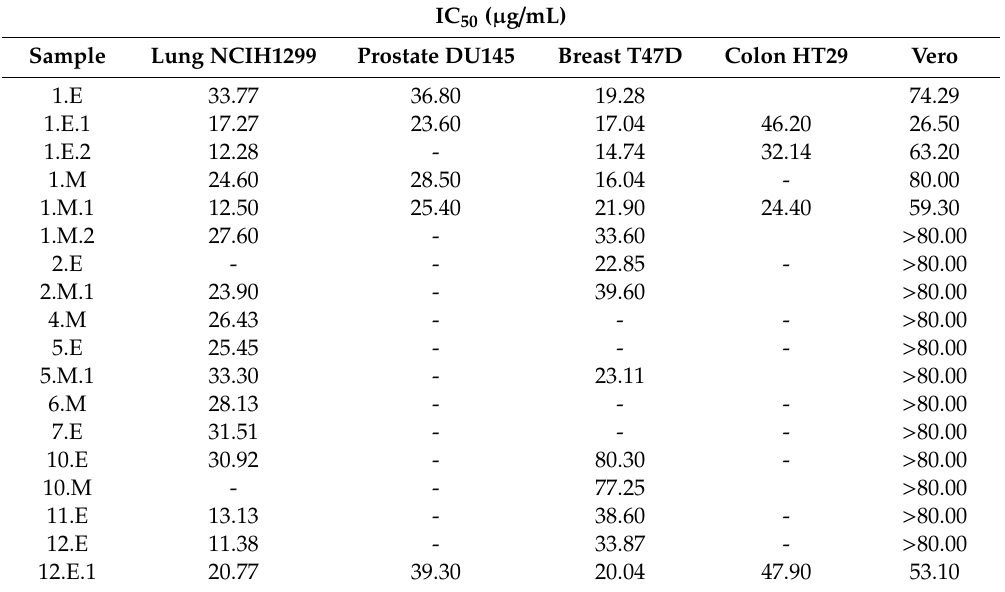
Figure 1. Cell survival against NCI-H1299 lung cancer cell line of samples (beach-cast extracts and fractions) tested at two concentrations (20 µg/mL and 50 µg/mL). Adriamycin at 5.43 µg/mL was used as reference. Table 2. IC 50 values of samples showing anticancer activity against di ff erent cancer cell lines studied. IC 50 ( µ g /